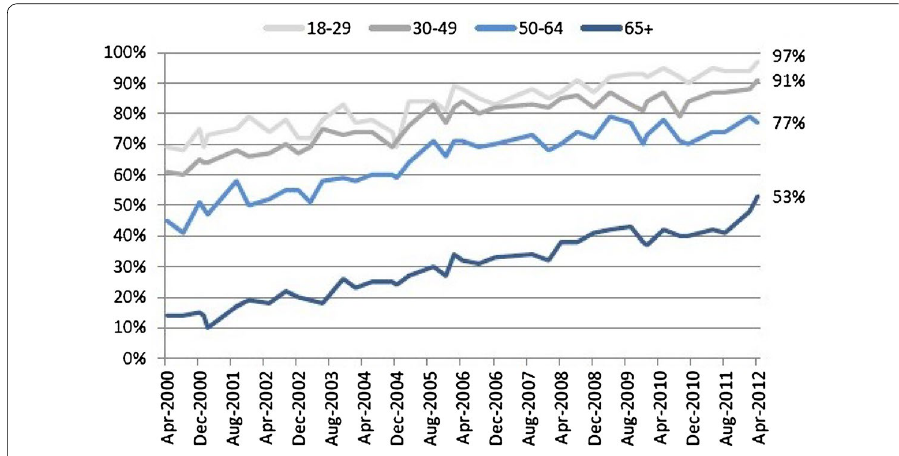
Fig. 1 Internet use by age group in America, 2000–2012 (Source: Zichuhr and Madden 2012)